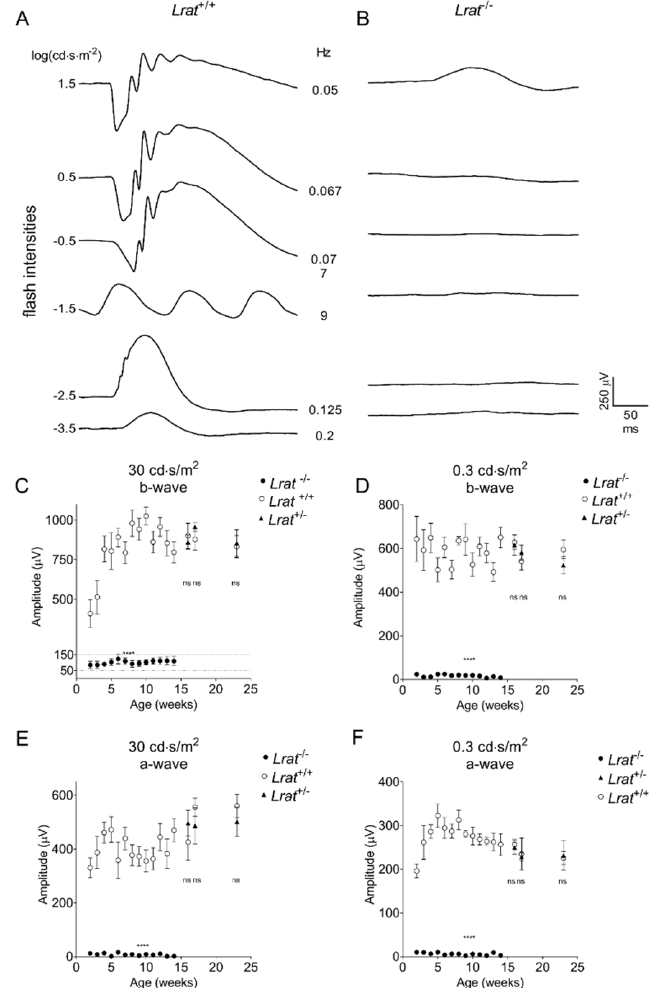
Figure 7. ERG responses of Lrat +/+ ( n = 6), Lrat +/ − ( n = 5), and Lrat − / − ( n = 6) animals after a single light flash. Averaged traces with increasing flash intensities are plotted for Lrat +/+ ( A ) and Lrat − / − animals ( B ) at 5 weeks of age. A-wave ( C , D ) and b-wave ( E , F ) amplitudes ( µ V) are plotted versus the age of the animals after a high light intensity flash (30 cd · s/m 2 ) ( C , E ) and a lower light intensity flash (0.3 cd · s/m 2 ) ( D , F ). No significant difference can be observed between the amplitudes of Lrat +/+ (white circles) and Lrat +/ ‐ animals (triangles). Lrat − / − animals (black circles) have extremely decreased or not detectable ERG responses from 2 weeks of age onwards ( C – F ). No dark ‐ adapted a ‐ wave responses were recorded at all, and no b ‐ wave response for 0.3 cd ∙ s/m 2 . ns = non ‐ significant; **** = p < 0.0001.